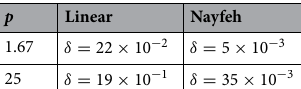
Table 2. Relative error for different approximations of angular frequency.